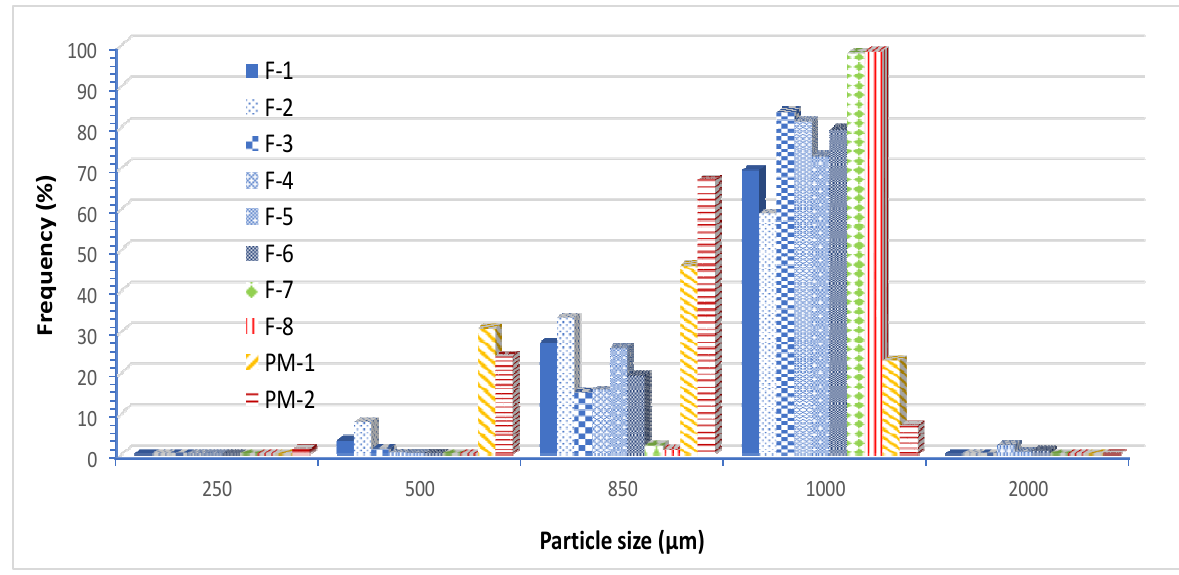
Figure 2. Particle size distribution of all formulations.